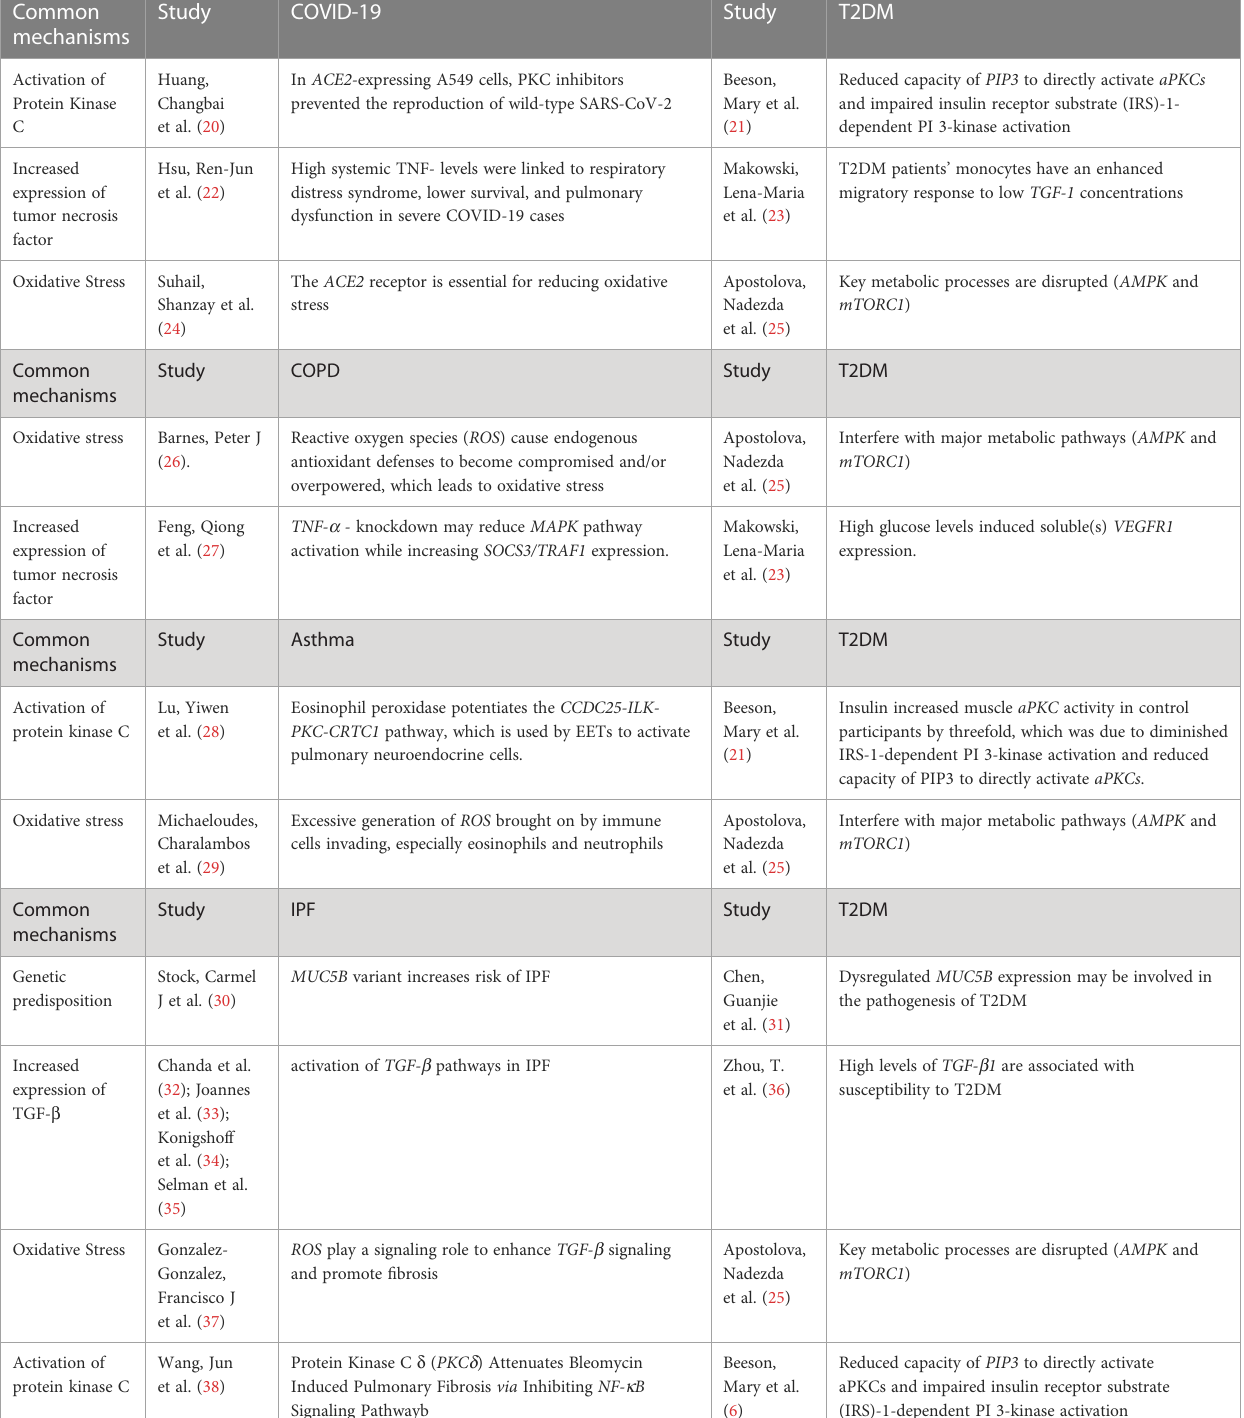
Table 1 By identifying common signaling pathways between diabetes and pulmonary dysfunction in respiratory diseases, we sought to identify the mechanisms of lung function deterioration in diabetes combined with COVID-19, asthma, COPD, and IPF. The common mechanisms of COVID-19 in combination with diabetes mellitus are protein kinase C, tumor necrosis factor, and oxidative stress. The common mechanisms of COPD are oxidative stress and tumor necrosis factor. The common mechanisms associated with asthma are protein kinase C and oxidative stress. ACE2, angiotensin converting enzyme-2; SARS-CoV-2, severe acute respiratory syndrome coronavirus 2; PIP3, Phosphatidylinositol-3,4,5-triphosphate; aPKC, Atypical protein kinase C; TGF- b 1, Transforming growth factor beta 1; AMPK, AMP-activated protein kinase; mTORC1, mammalian target of rapamycin complex 1; SOCS3, Suppressor Of Cytokine Signaling 3; MAPK, Mitogen − activated protein kinase; TRAF1,TNF Receptor Associated Factor 1; CCDC25, Coiled-coil domain containing 25; ILK, Integrin-linked kinase; PKC, Protein kinase C; CRTC1,CREB- regulated transcription coactivator 1; MUC5B, Mucin